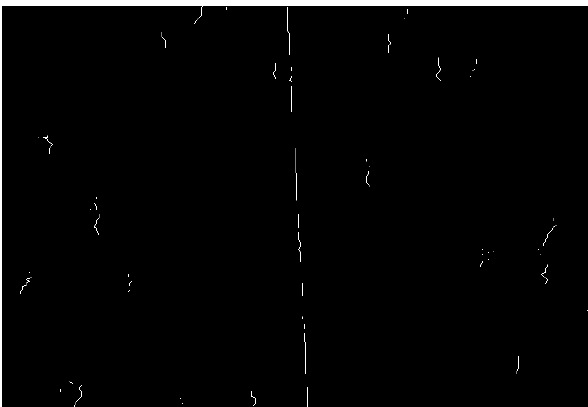
Figure 9. Partially enlarged image of the results of the first refinement of power line features.